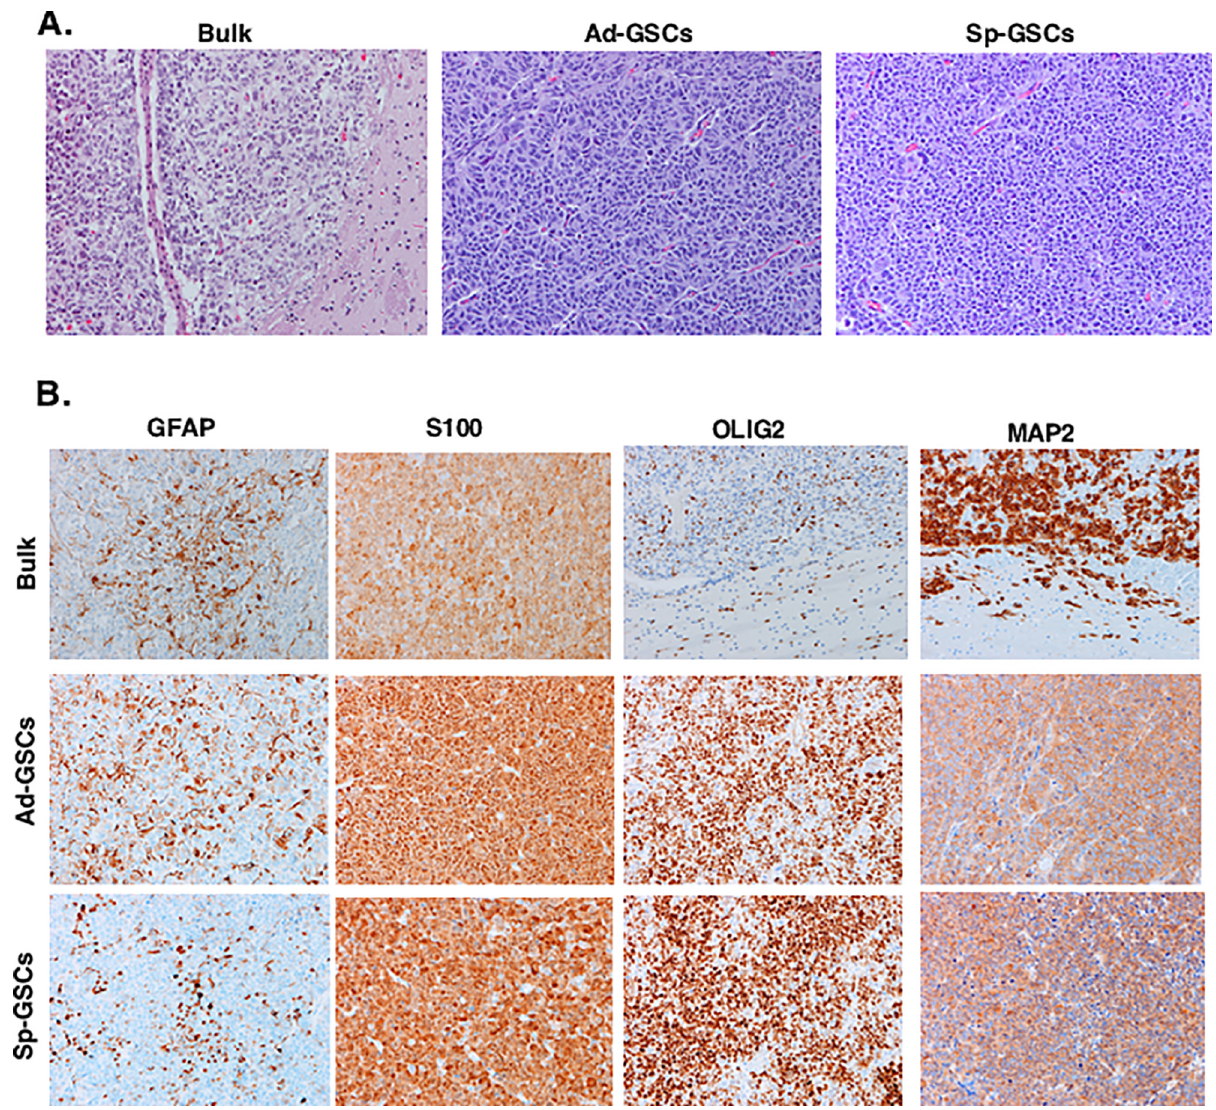
Fig 5. Pathologic analysis of orthotopic GBM6 tumor xenografts. GBM6 bulk tumor cells, Ad-GSCs and Sp-GSCs were orthotopically injected as described in Fig 4, and tumor-bearing brains were paraffin embedded for histology. A. H&E staining and B. Immunoreactivity for GFAP, S100, OLIG2 and MAP2. (All photomicrographs taken at